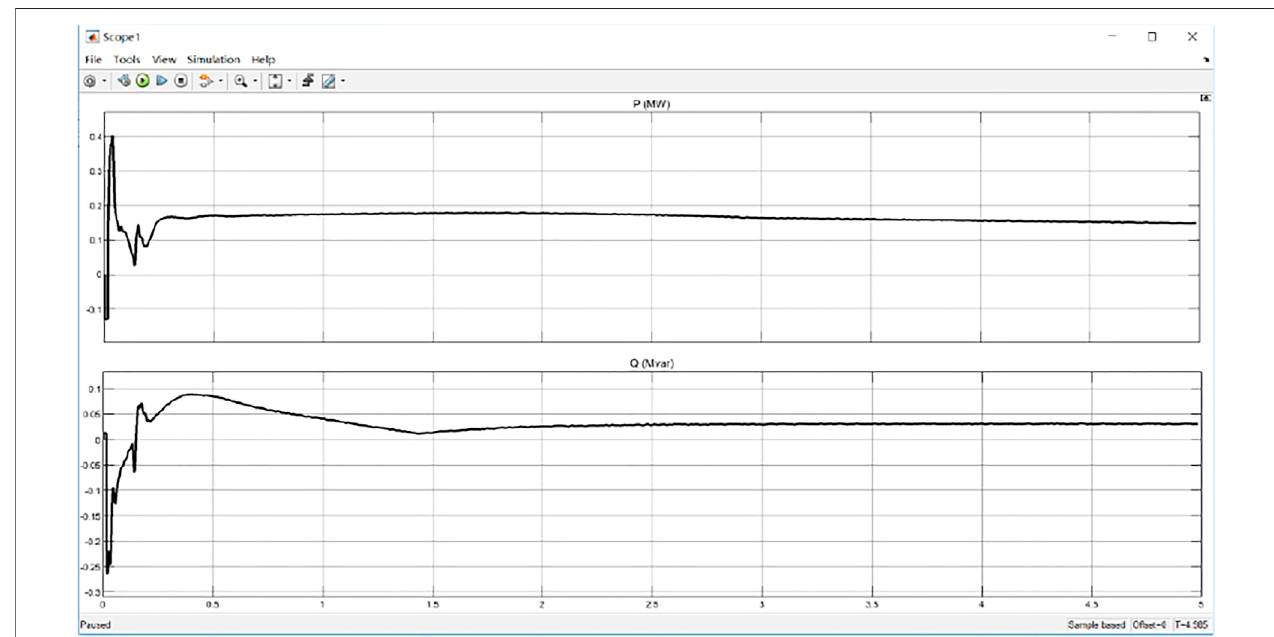
FIGURE 14 | Variation curve of the wind farm power de fi cit.